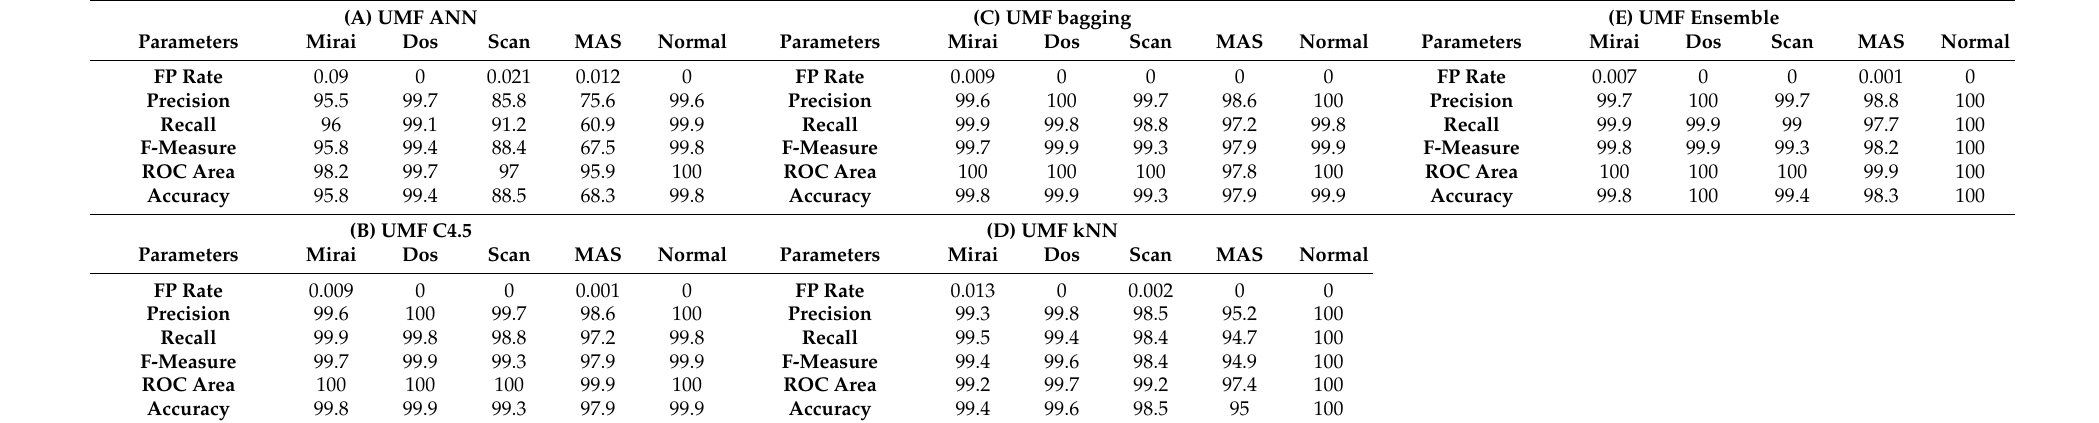
Table 12. Summary of calculated statistical parameters for test IoTID20 dataset using union theory with the best 28